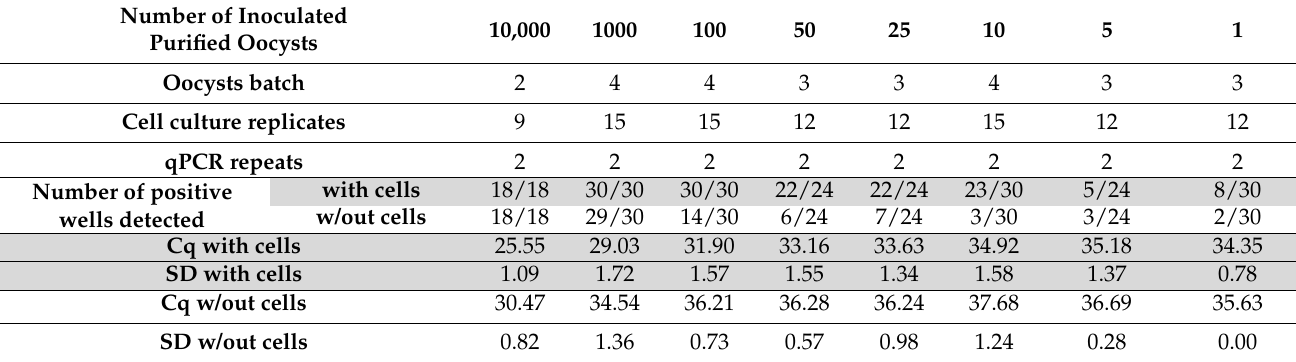
Table 1. Cell culture and quantitative PCR (CC–qPCR) assay results for purified C. parvum oocysts.